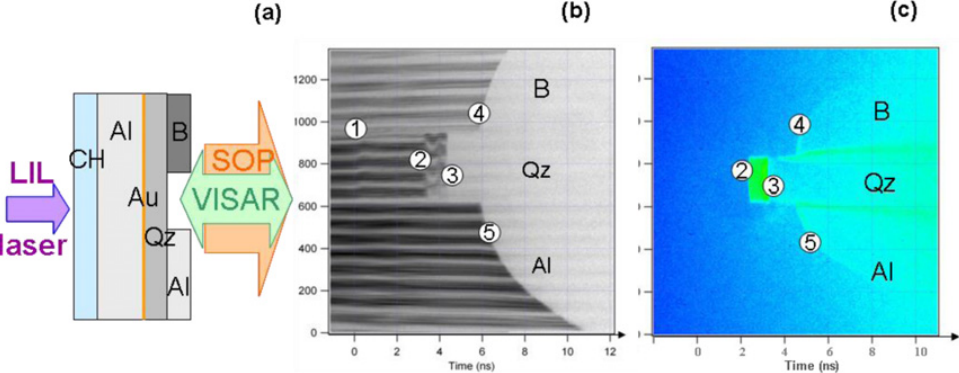
Figure 4. EOS experiment configuration (a); VISAR (b) and SOP (c)